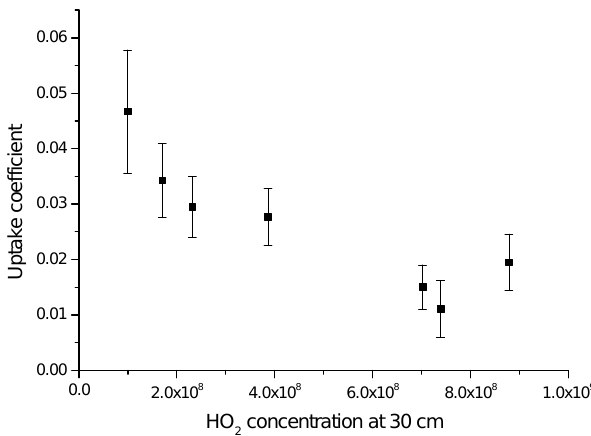
Figure 7. HO 2 uptake coefficients measured at different HO 2 concentrations, which were determined at an injector position of 30 cm when no dust aerosols were present in the aerosol flow tube. The error bars represent one standard deviation of a number of repeated experiments for a given HO 2 concentration.